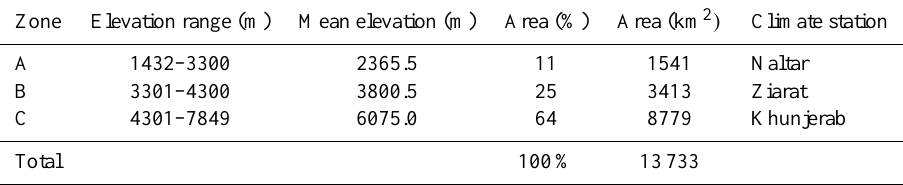
Table 2. Characteristics of the three elevation zones extracted from the GDEM of the Hunza River basin and their corresponding climate